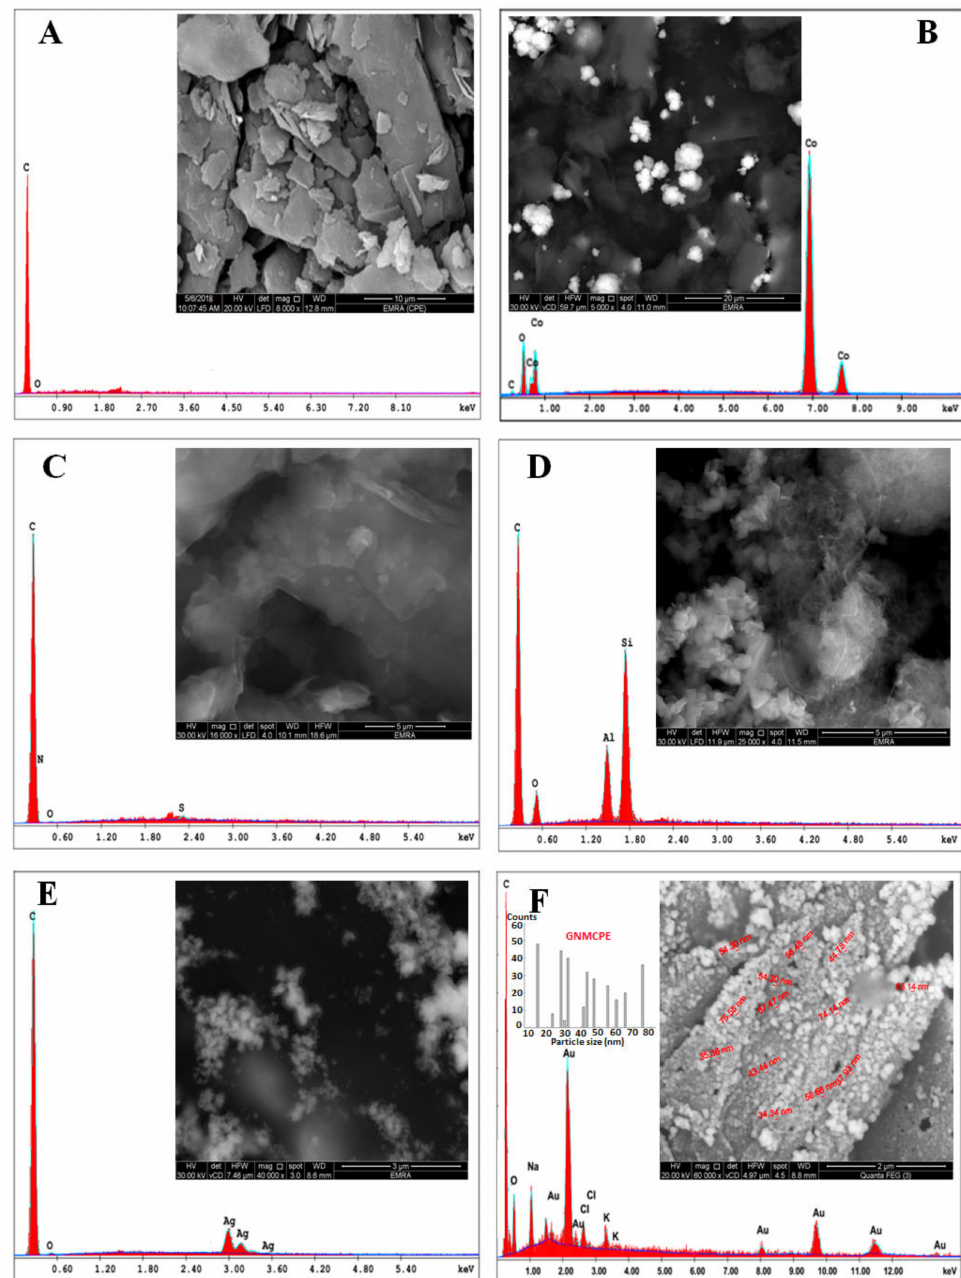
Figure A1. EDX spectra and SEM micrographs (insets) of ( A ) BCPE, ( B ) NCOMCPE, ( C ) GORGMCPE, ( D ) ZCNTMCPE, ( E ) SCCMCPE and ( F ) GNMCPE with its histogram,